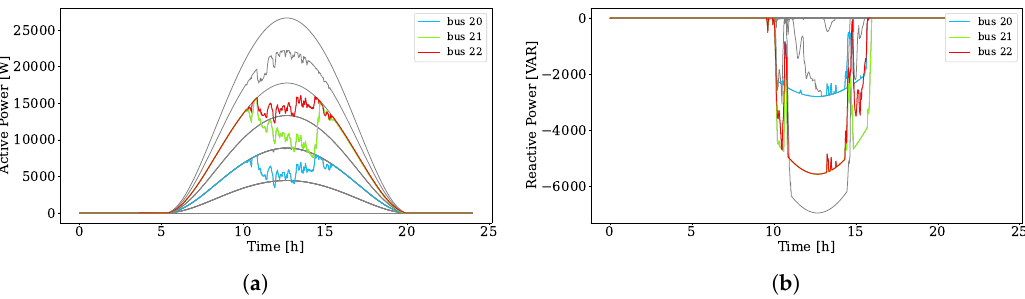
Figure 8. Distributed control applied only to DG. ( a ) Active power generated by PVs ( b ) Reactive power generated by PVs.